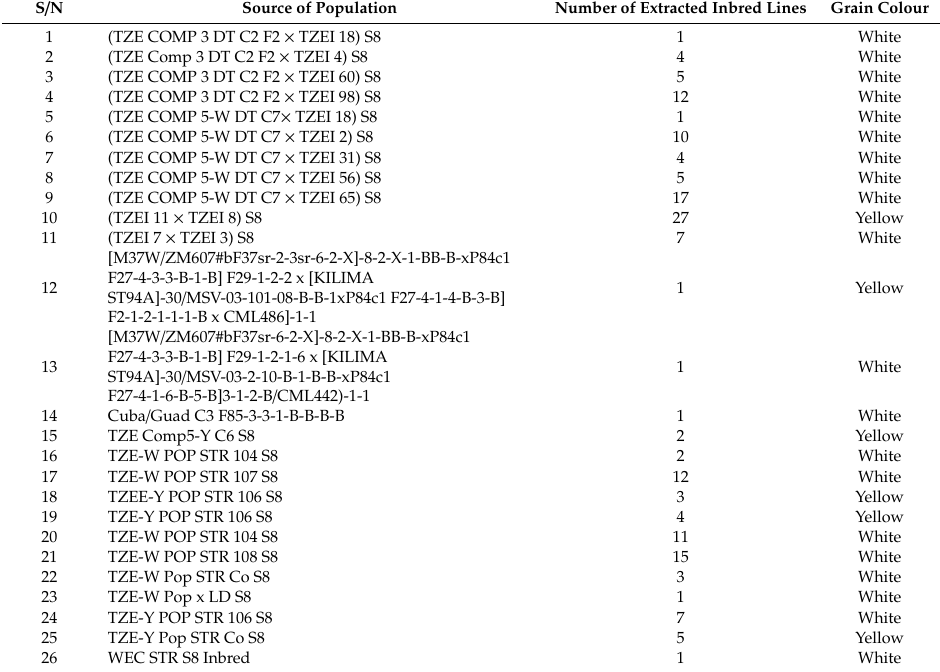
Table 1. Source populations of 162 maize inbred lines used in the genetic diversity study. S / N Source of Population Number of Extracted Inbred Lines Grain